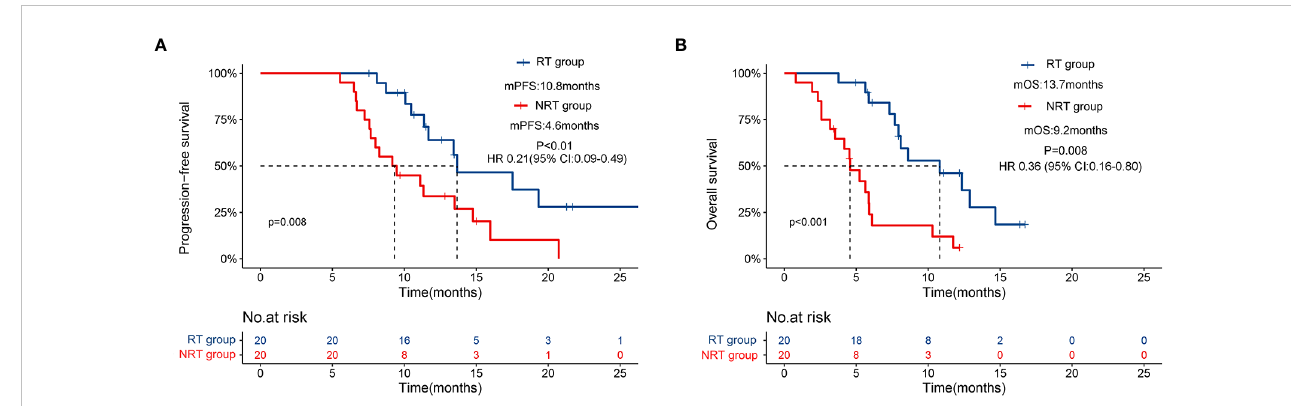
FIGURE 2 Kaplan – Meier curves for progression-free survival (A) and overall survival (B) for patients receiving PD-1 inhibitors plus lenvatinib with or without